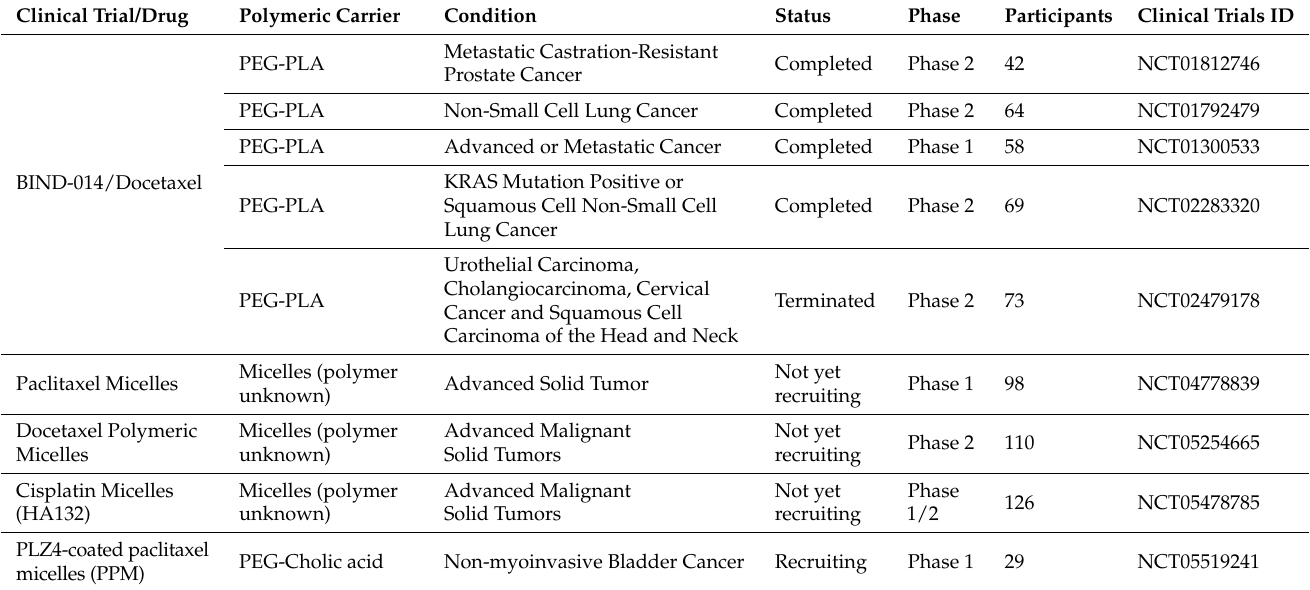
Table 4. The clinical trials of polymeric